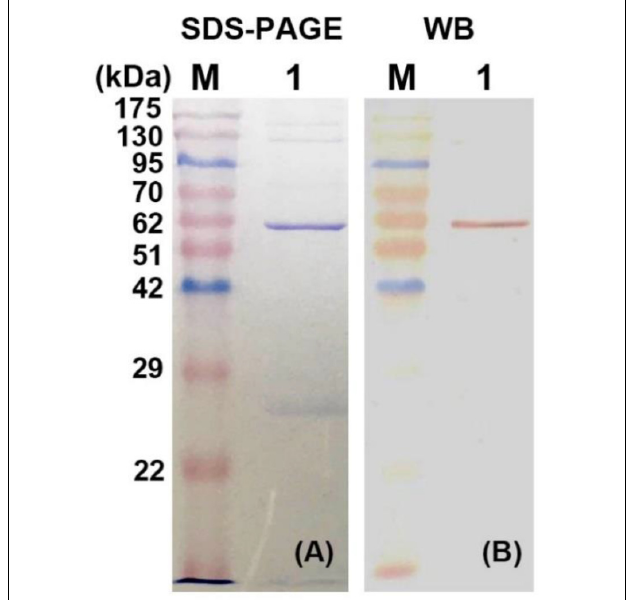
FIGURE 3 | Expression and purification of recombinant BpEG. (A) The SDS-PAGE analysis of purified recombinant BpEG. (B) Western blot analysis of purified recombinant BpEG. M, opti-protein marker/ladder (Applied Biological Materials, Inc., Canada); 1, purified endo-1,4- β -glucanase.